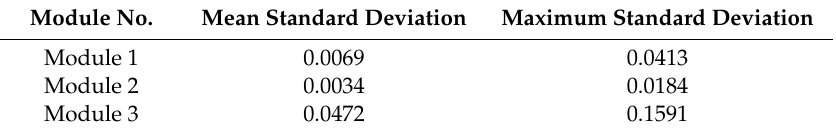
Table 7. SOC standard deviation of cells in modules under UDDS working